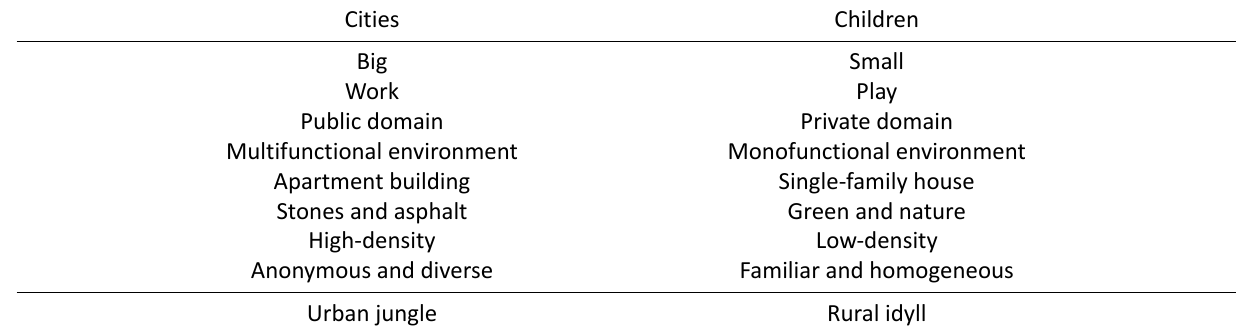
Table 1. Defining elements of cities and